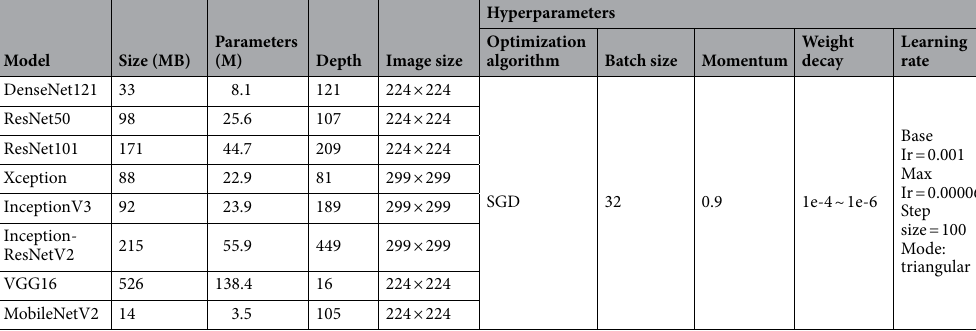
Table 2. Specifics of the CNN architectures applied and tested in this study. CNN Convolutional Neural Network, MB MegaBytes, M Million Parameters, SGD Stochastic Gradient Descent.